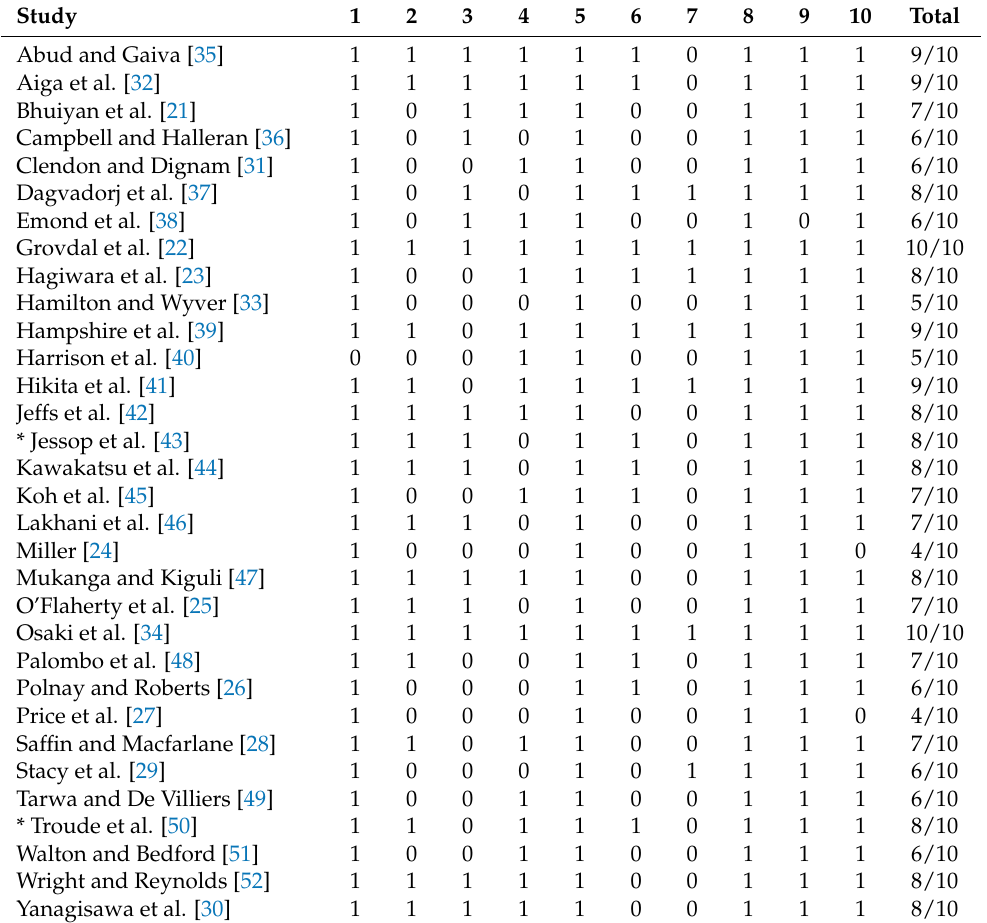
Table 1. Quality assessment/risk of